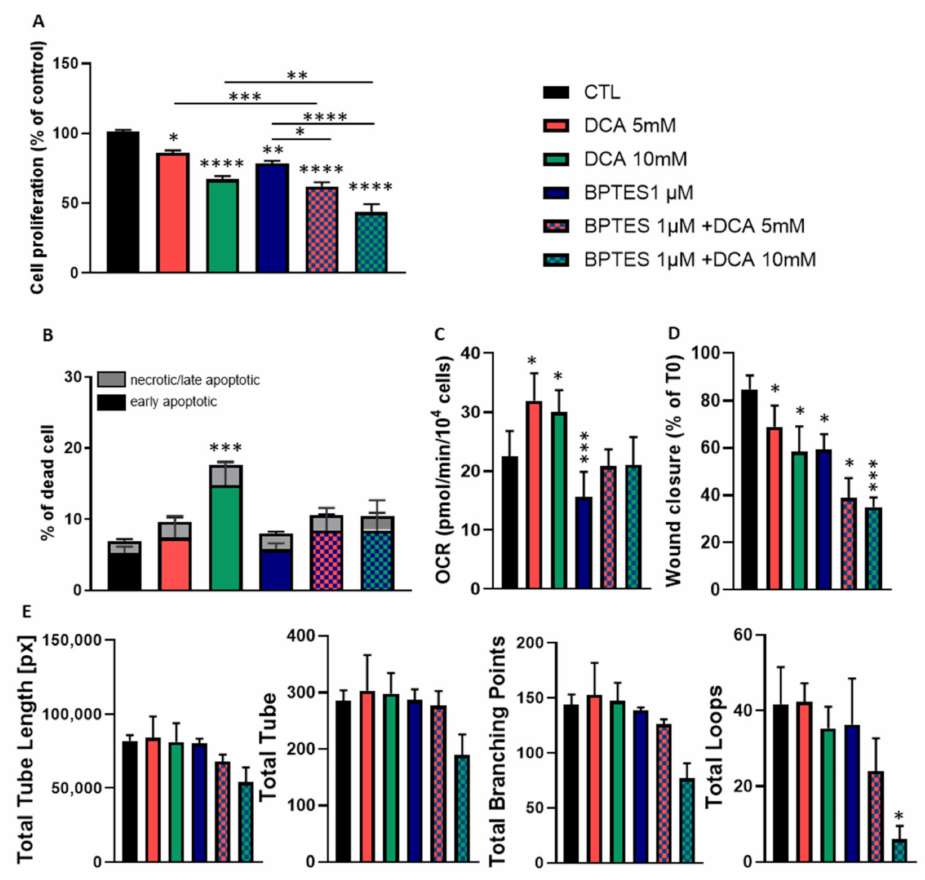
Figure 4. Combined exposure to DCA and BPTES enhances the reduction in HUVECs proliferation and migration but normalizes OCR and apoptosis. ( A – E ), HUVECs were treated with DCA (5 or 10 mM) and BPTES (1 µ M), alone and in combination. The following parameters were evaluated: ( A ), cell proliferation ( n = 4), ( B ), apoptotic and dead cells ( n = 4), ( C ), oxygen consumption rate ( n = 3), ( D ), wound closure ( n = 3) and ( E ), tube formation ( n = 3). Statistical analysis: One-way ( A , C – E ), or Two-way ANOVA ( B ) (Sidak’s multiple comparison test), comparison with control except for A where specific pairs are noted with a black line, * p < 0.05, ** p < 0.01, *** p < 0.001, **** p <